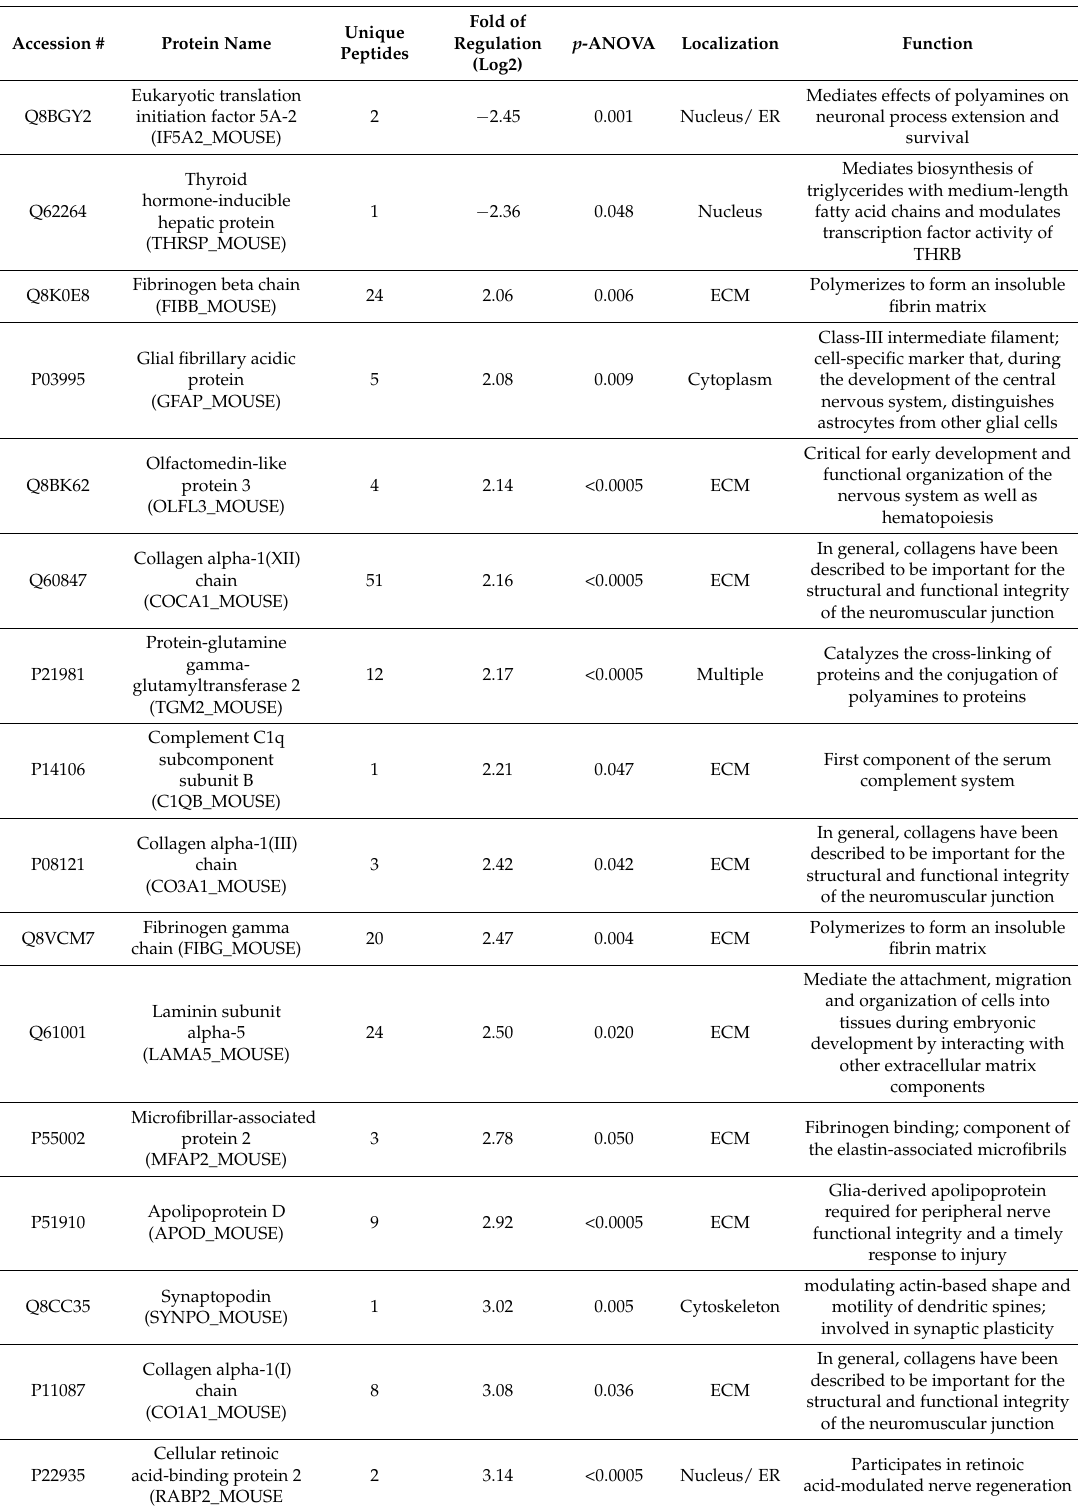
Table 1. List of relevant proteins and their subcellular localizations and functions identified with altered abundances in sciatic nerves from eight-month old Sh3tc2 ∆ Ex1 / ∆ Ex1 mice. All listed proteins have been quantified based on at least one unique peptide. ECM: extra-cellular